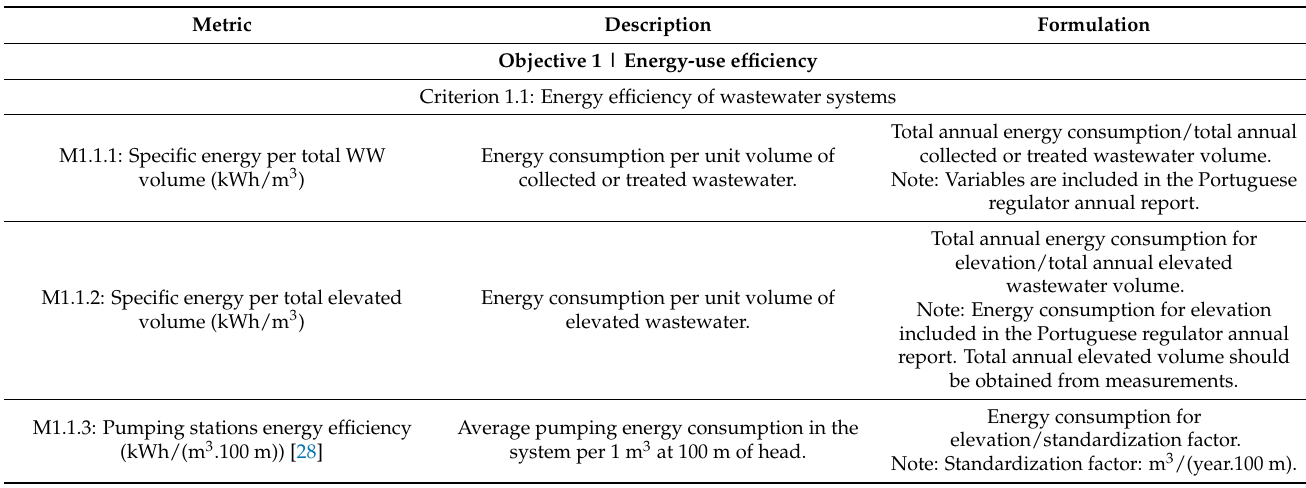
Table A1. Complete metrics description and